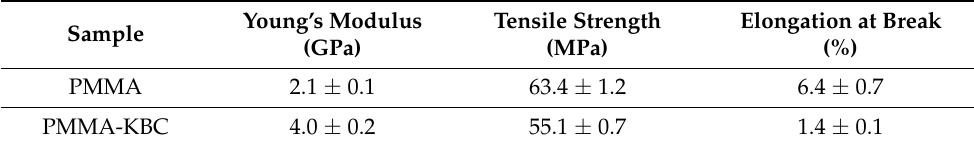
Table 2. Mechanical properties of neat PMMA and PMMA-KBC nanocomposite.